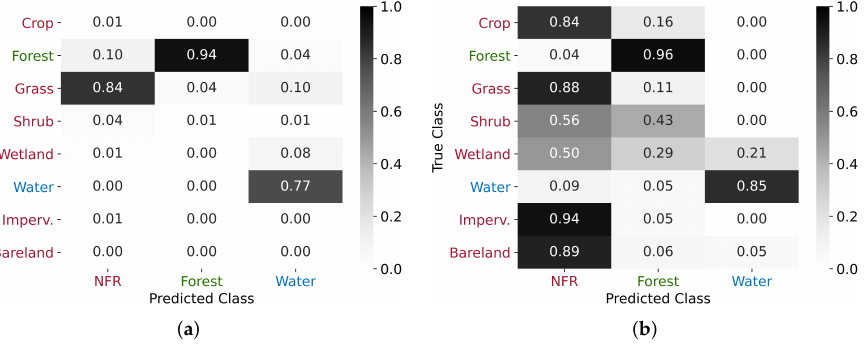
Figure 10. Confusion matrices normalized by ( a ) the predicted and ( b ) the true classes, considering the original labels of the eight available FROM-GLC